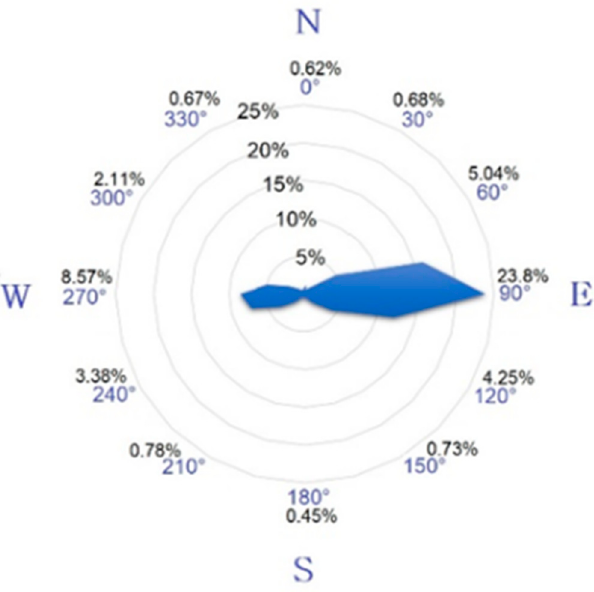
Figure 7. Wind direction distribution.